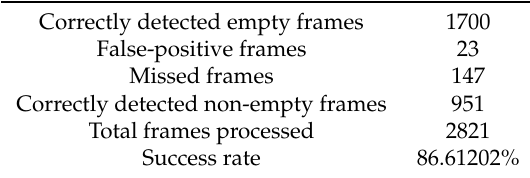
Table 3. Frame count breakdown for aMussel detection